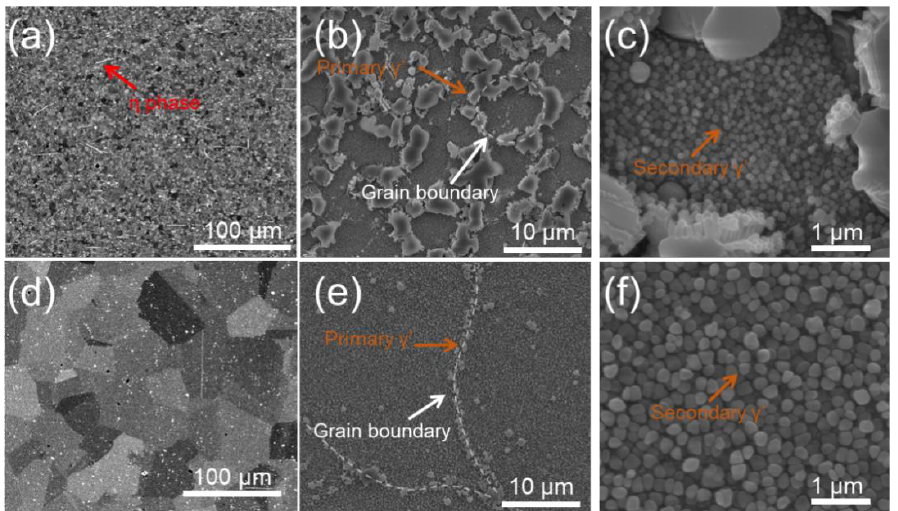
Figure 1. The microstructure of PM superalloy before heat treatment taken by optical microscopy.